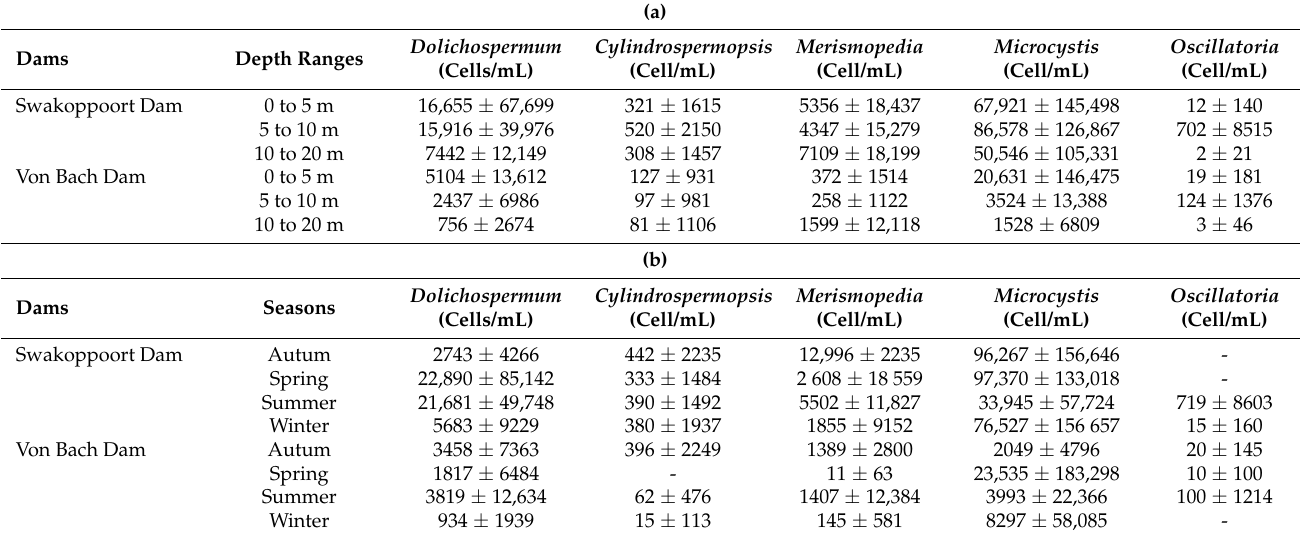
Table 5. The average ± standard deviation of the abundance of cyanobacteria species observed in Swakoppoort and Von Bach dams at (a) different depth ranges and (b) among seasons.